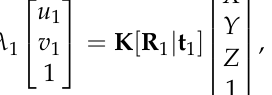
Figure 7. Principle of multi-ocular reconstruction.